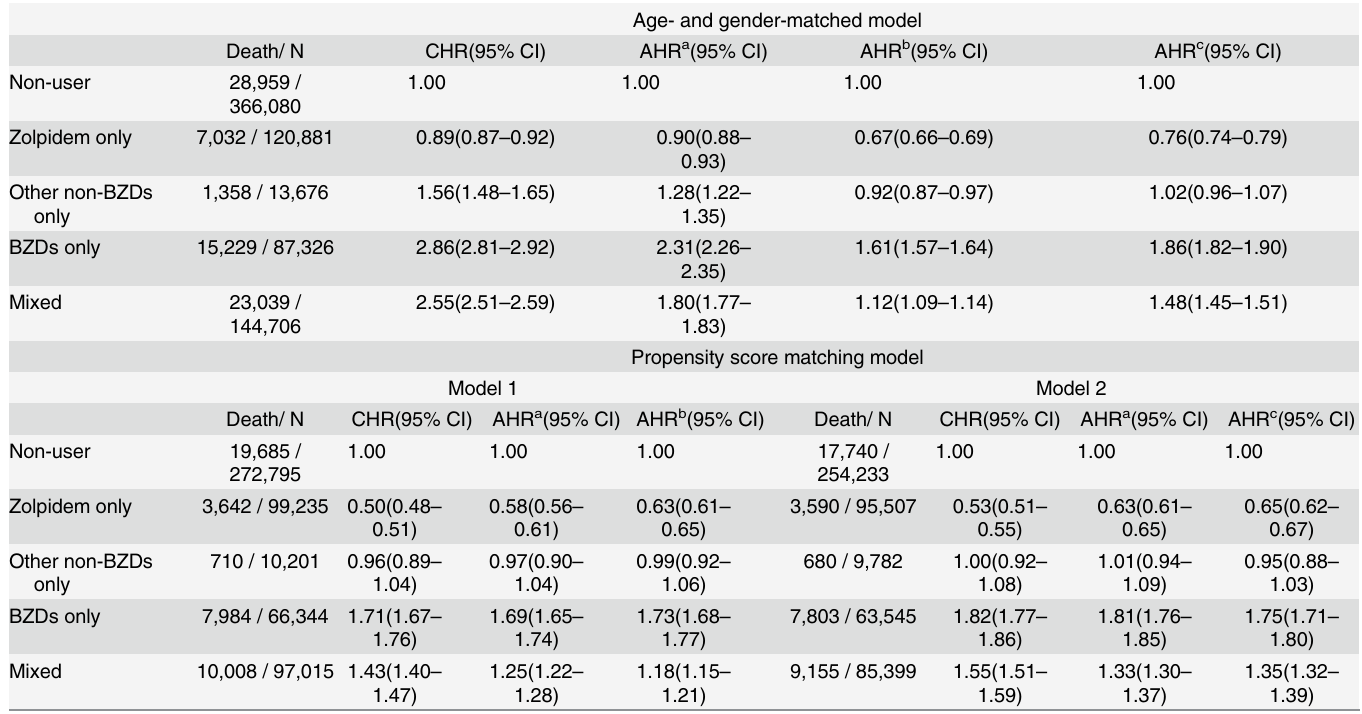
Table 4. Crude and adjusted risk of mortality for age- andgender-matching and propensity score matching.